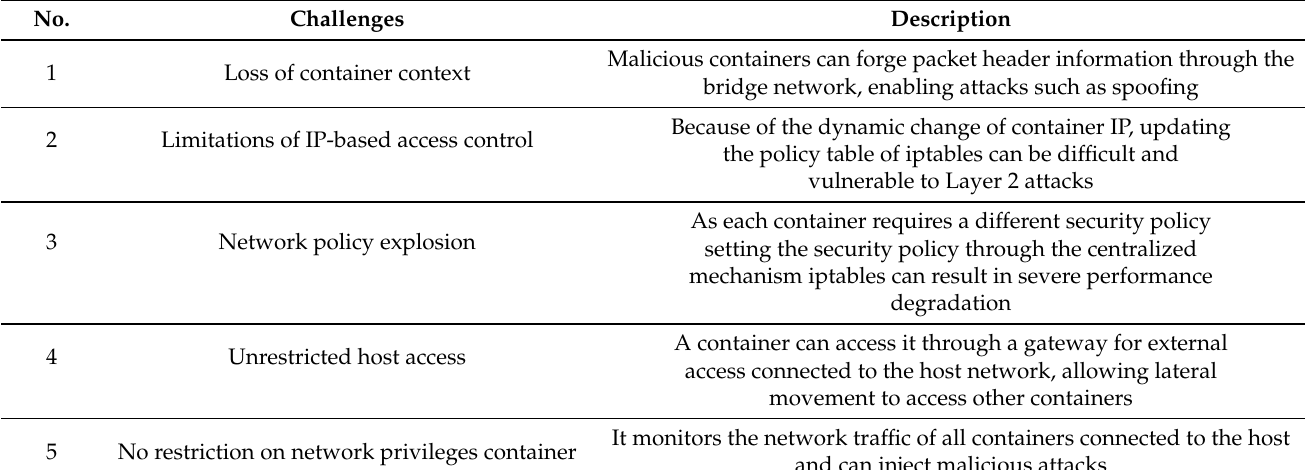
Table 3. Challenges in Docker container networks [24].